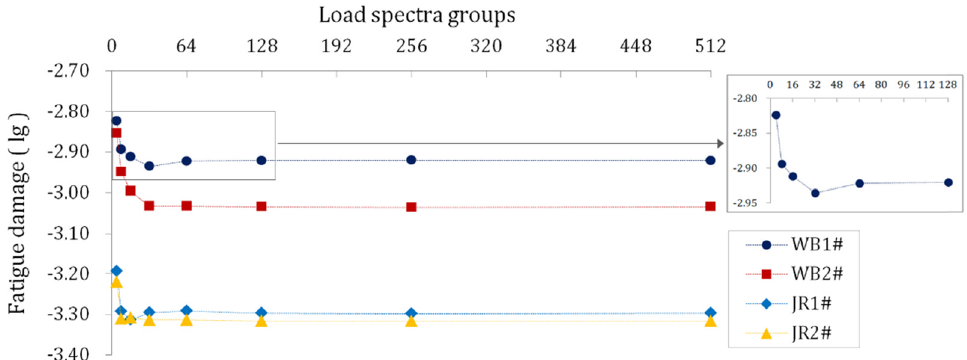
Figure 19: Fatigue damage convergence with load spectra